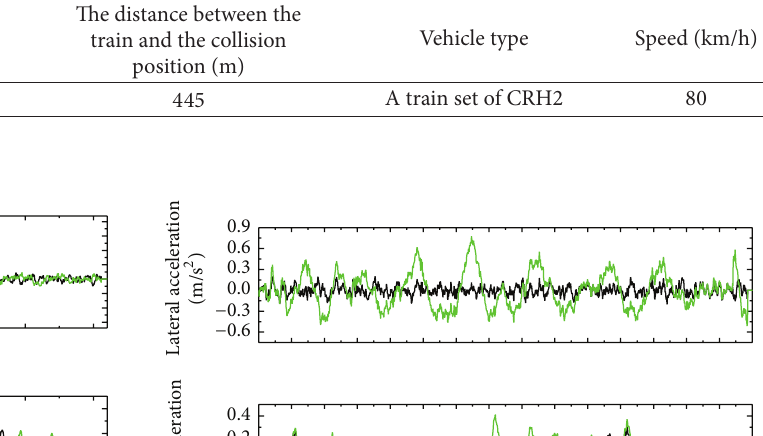
Table 4: Calculation condition of a train (in the down direction).